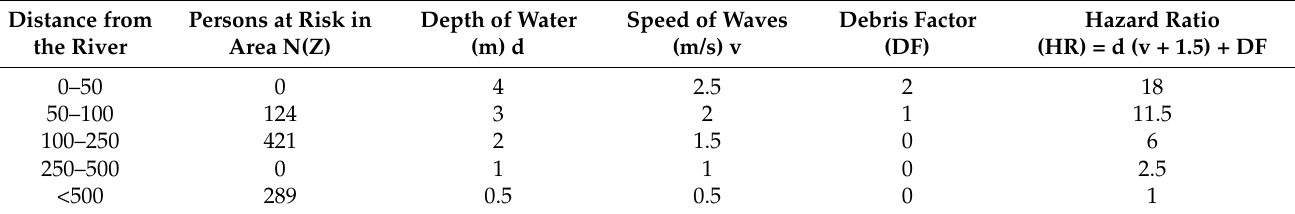
Table 1. Calculation of hazard ratio (HR).